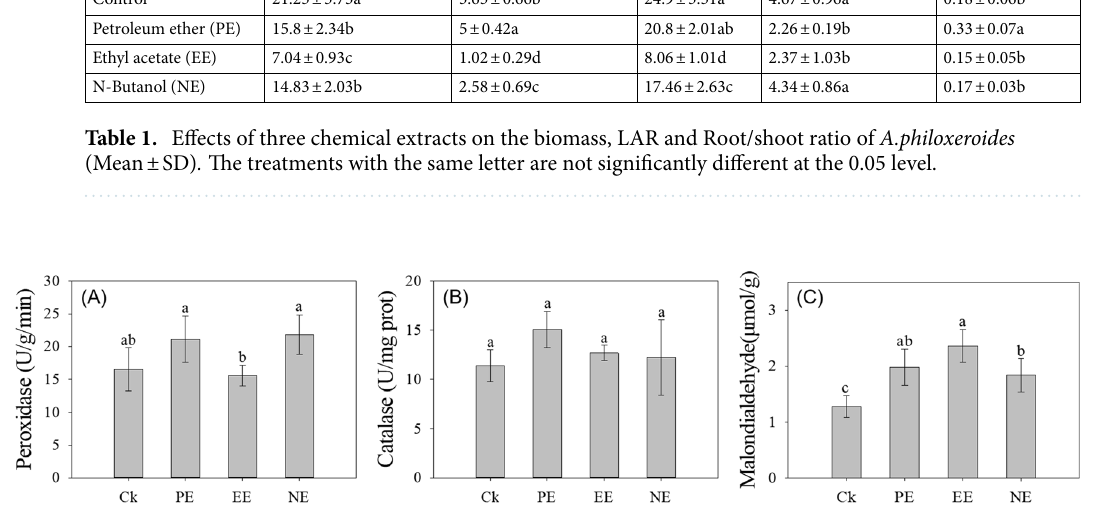
Figure 2. The effect of the three chemical extracts on the leaf enzymes , ( A ) POD activity and ( B ) CAT activity and ( C ) MDA content, of A. philoxeroides (from left to right, the bars are control, PE, EE and NE, respectively). The treatments with the same letter are not significantly difference at 0.05